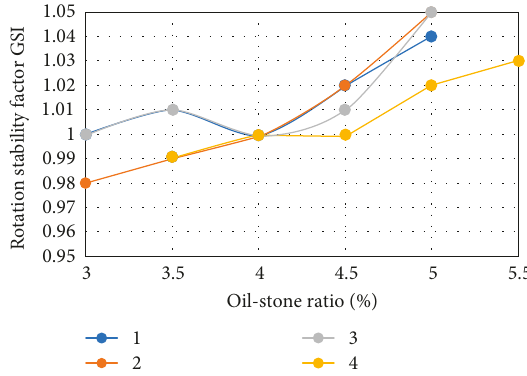
Figure 3: Relation between AC-16 mineral material clearance rate and oil-stone ratio.